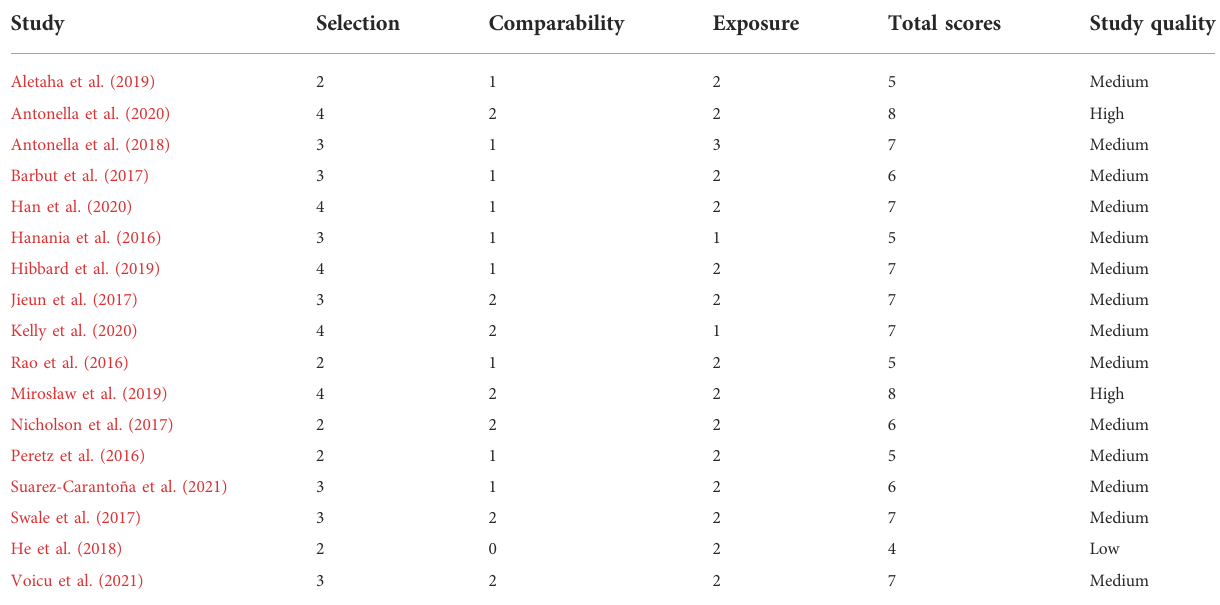
TABLE 3 Quality scores of included